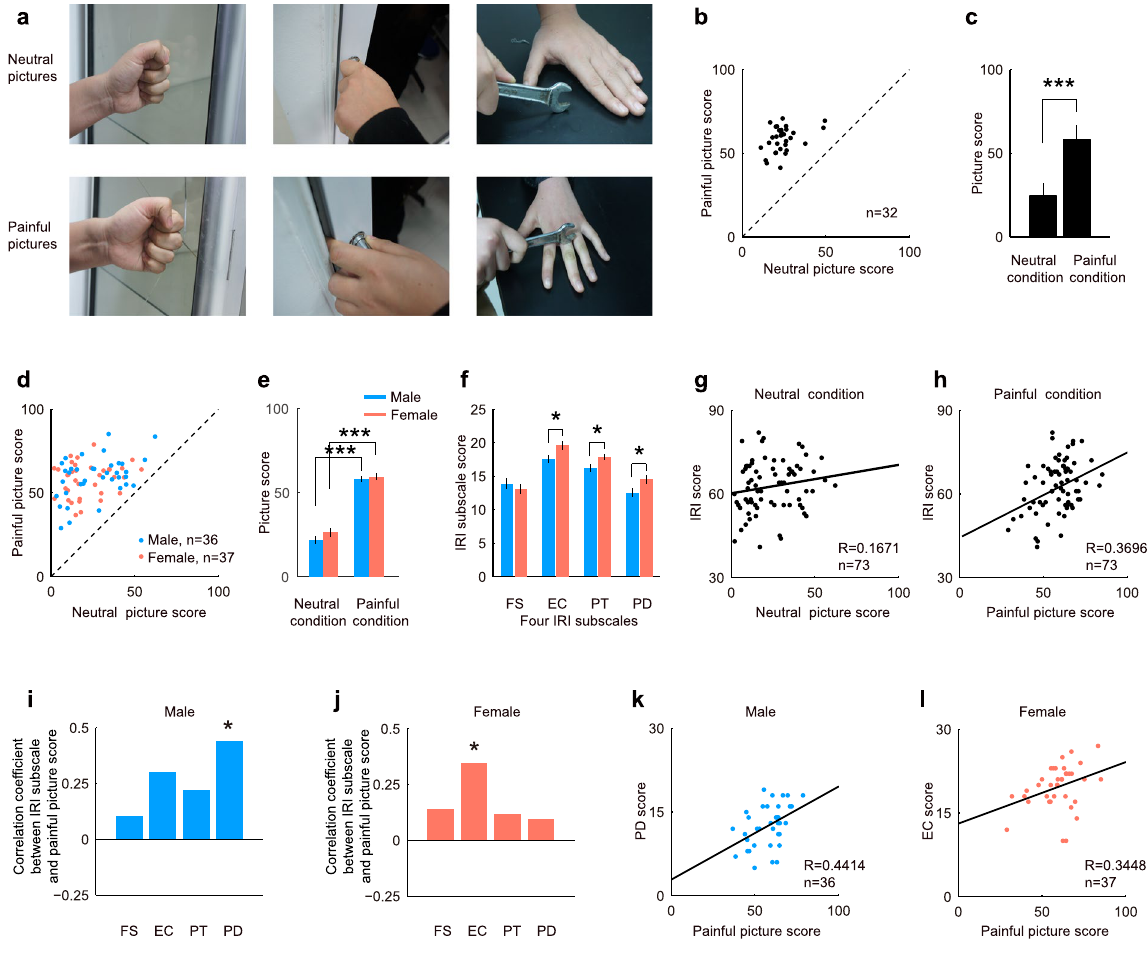
Figure 1. Examples of the pictures used to elicit empathic pain and the subjects’ responses. (a) Three example pairs of pictures. In total, 32 pairs of photographs were used, and each pair contained one painful picture and one corresponding neutral picture. (b) Subjects’ subjective evaluation of the empathic pain scores of every picture pair. Each dot represents the mean empathic pain scores of the painful and neutral pictures in one pair. (c) The empathic pain scores of painful pictures were significantly higher than those of the neutral pictures ( P < 0.001, d.f. = 31, paired t -test, d = 4.3133). (d) The empathic pain scores of the painful and neutral pictures evaluated by the male (blue dots) and female (red dots) subjects. (e) Both male and female subjects gave higher marks to the painful pictures than to the corresponding neutral pictures (male, P < 0.001, d.f. = 35, d = 3.0333; female, p < 0.001, d.f. = 36, d = 2.2921, paired t -test). (f) An empathy questionnaire, the Interpersonal Reactivity Index (IRI) was employed to measure the empathy skills of individual subjects. IRI has four seven- item subscales, including fantasy (FS), empathic concern (EC), perspective-taking (PT) and personal distress (PD). Females displayed higher scores than males on the last three subscales, EC, PT and PD, but not on FS (FS, P = 0.47, d.f. = 71, d = 0.17; EC, P = 0.0213, d.f. = 71, d = 0.5511; PT, P = 0.0284, d.f. = 71, d = 0.5239; PD, P = 0.0354, d.f. = 71, d = 0.502, t -test). (g,h) Subjects exhibiting higher IRI scores generally gave higher marks to both neutral (g) and painful (h) pictures, but the IRI scores only significantly correlated with the painful picture scores (R = 0.3696, P = 0.0013). The solid lines represent linear regression. (i–l) , The IRI subscale, PD, significantly correlated with the painful picture scores for males ( i , k , R = 0.4414, P = 0.007); While another subscale, EC, significantly correlated with the painful picture scores for females ( j , l , R = 0.3448, P =